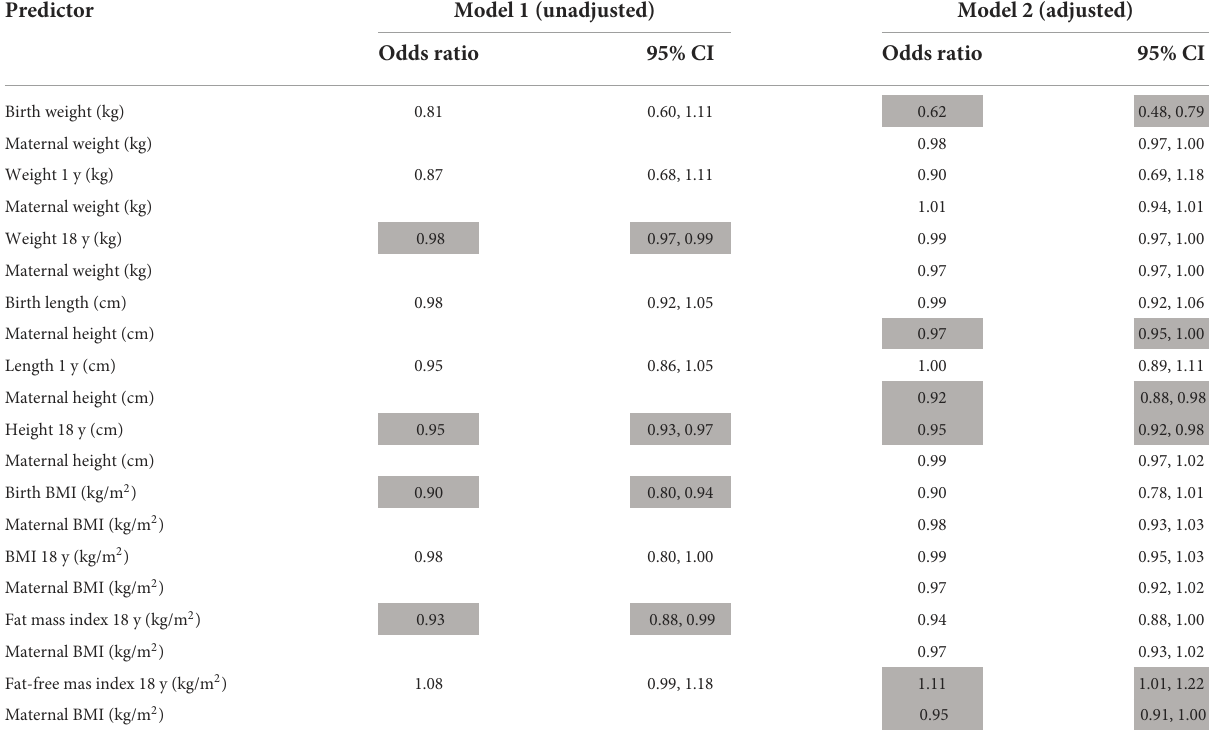
TABLE 5 Logistic regression models analysing the association of son’s growth phenotype with the odds of early reproduction, without/with adjustment for maternal phenotype. Predictor